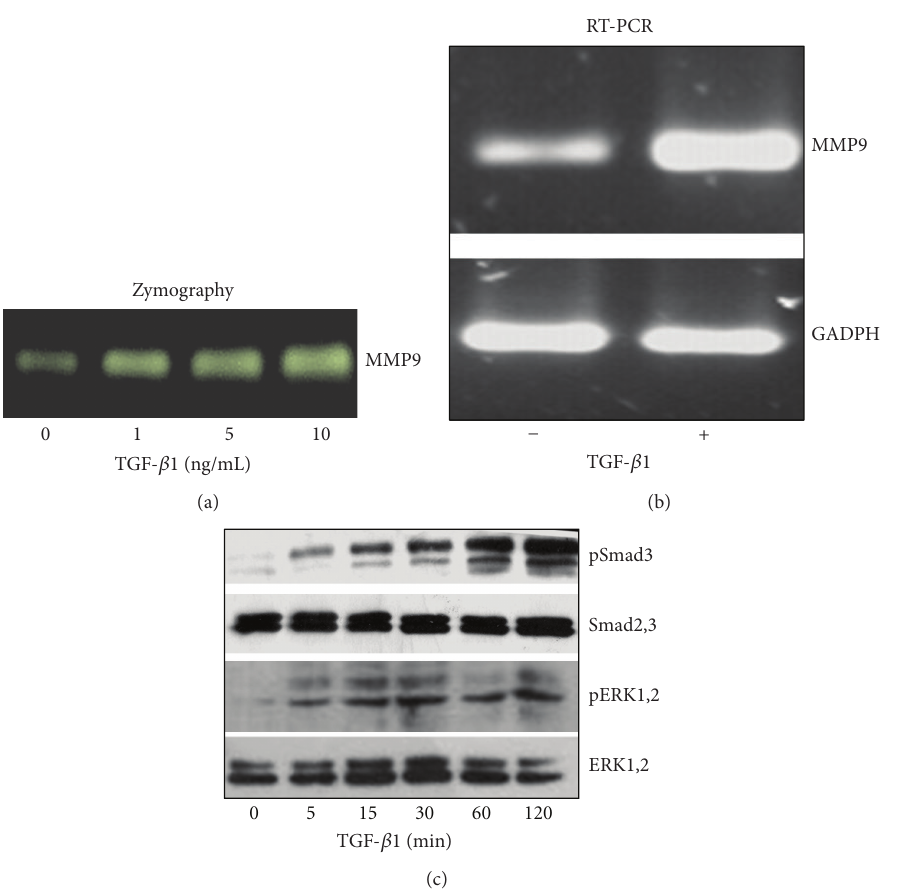
1inducesMMP-9expressionandactivatesSmad3andERK1,2signalingintransformedkeratinocytes,PDV.(a)Zymography analysis of MMP-9 in serum-free conditioned media. PDV cells were treated for 24h with different concentrations of TGF- collectedweresubjected toelectrophoresisonagelatin-polyacrylamidegel.(b) RT-PCRanalysisofMMP-9expression.PDVcellsweretreated for24hwith5ng/mlofTGF- 1,andmRNAobtainedwasreversetranscribedtocDNA.PCRproductswereseparatedinagarosegels.GADPH was used as housekeeper gene to verify the equal amount of cDNA in samples. (c) Western blot analysis for 𝛽𝛽